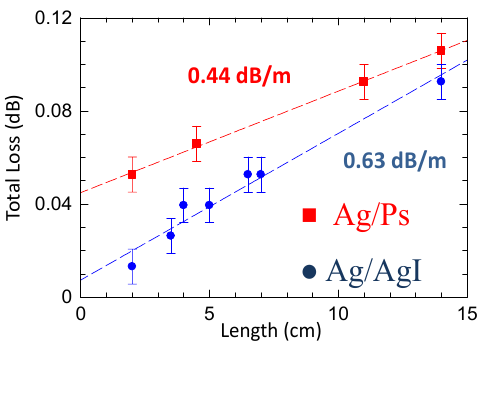
Figure 6. Total losses calculated from the ratio of input/output power values for the wavelength λ at the waveguide entrance/exit for Ag/AgI coatings ( ● symbols) and for a AgPs coatings ( ■ symbols). The dashed lines are linear fits to the data. The reported transmission losses have been estimated from the slope of each linear fit.